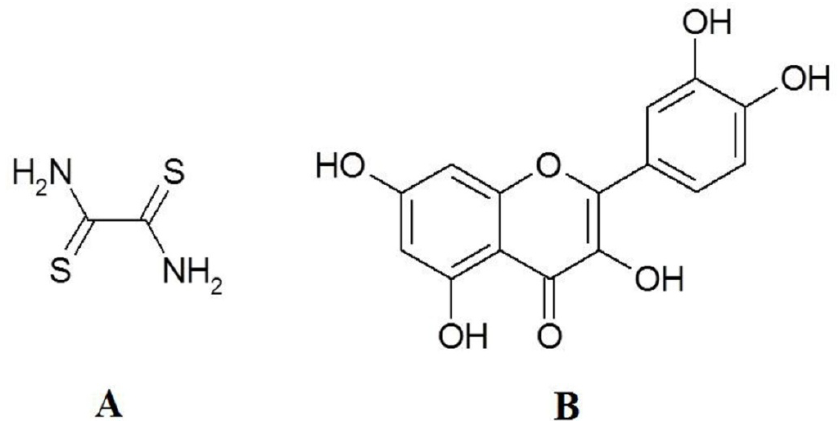
Figure 1. Structural features of ( A ) dithiooxamide (DTO) and ( B ) quercetin